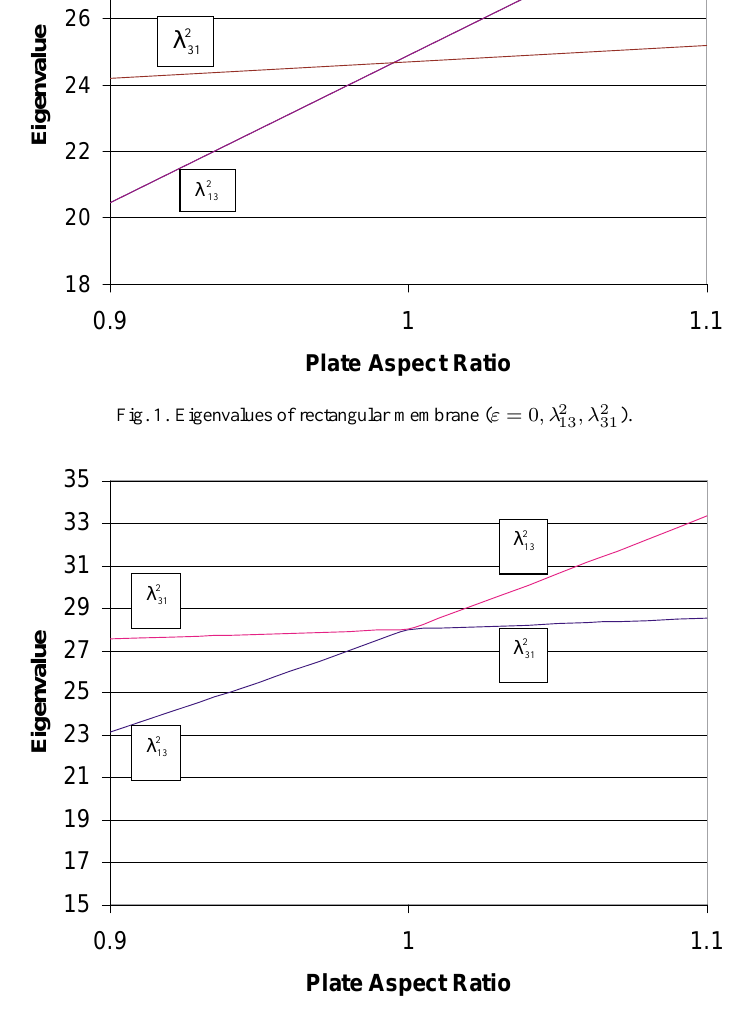
Fig. 2. Eigenvalues of rectangular membranes ( ε = 1000 , φ ∗ 13 = φ 13 + f 1 ,φ ∗ 31 = φ ∗ 31 = φ 31 + f 2